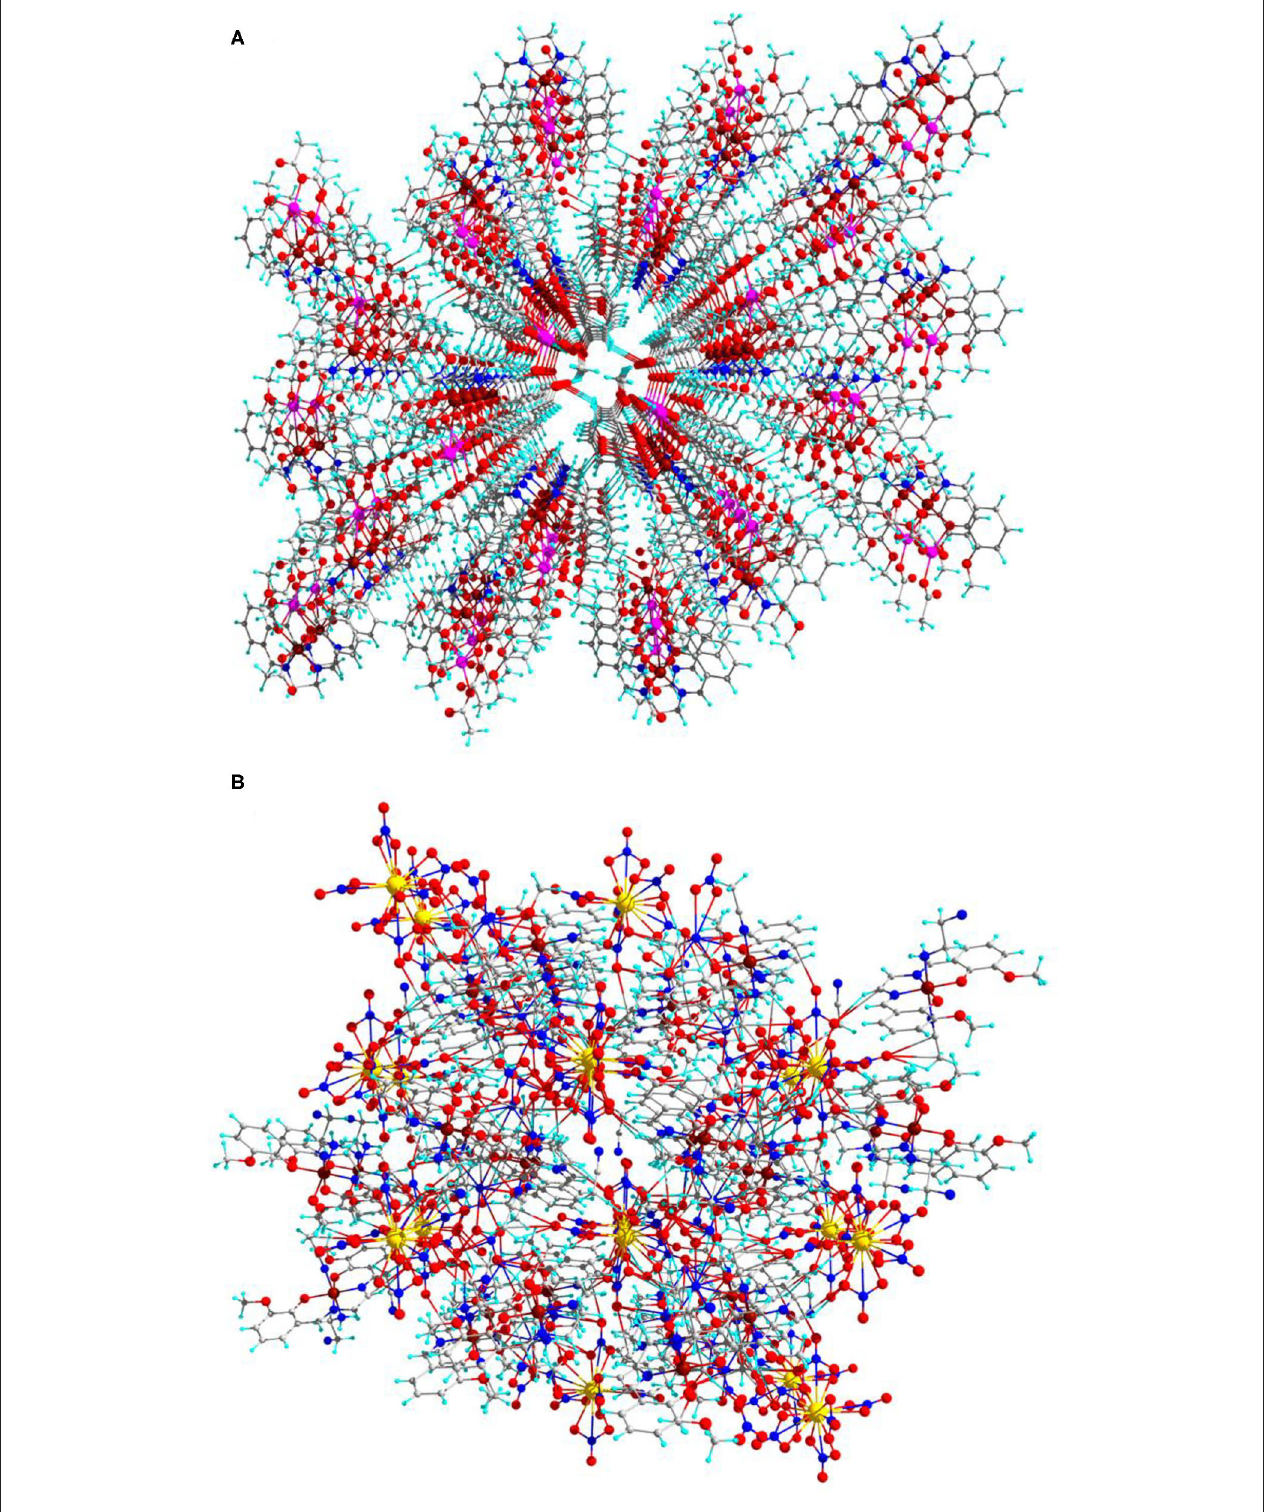
FIGURE 4 | Catenation 2D layers MOF (A) for complex 1 and (B) for complex 2 (central projection, along 100-a axis) in ball-and-stick model.